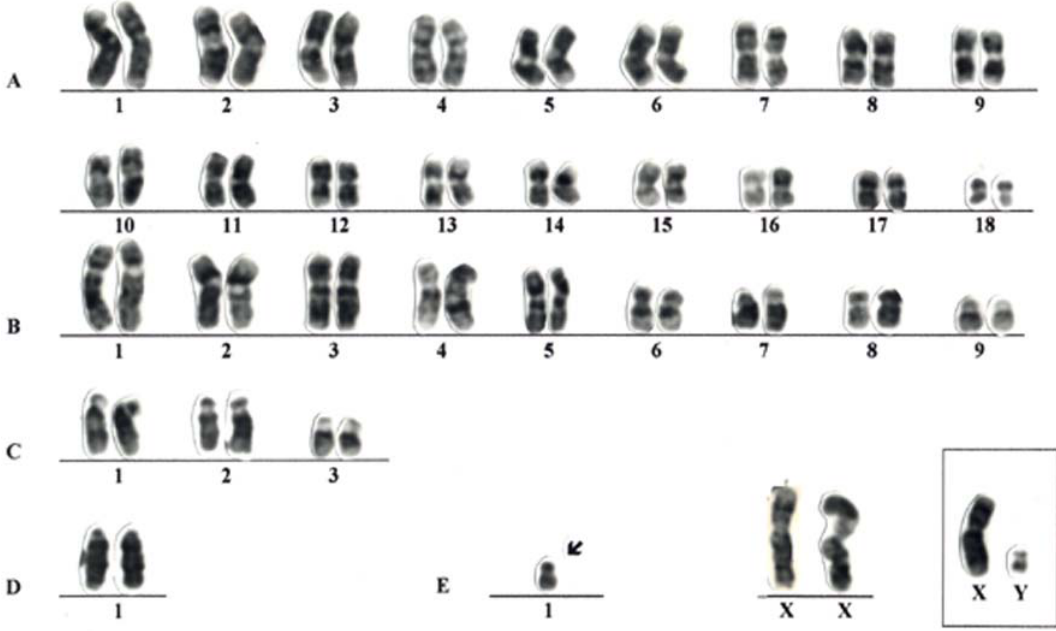
Fig. 4 – Banding G (GTG) standard of the lineage 2n=65 from a female sample of D. fuliginosa . The arrow points to the banded supernumerary chromosome. Standing out, it appears the sexual pair: X andY chromosomes, from a male of D. prymnolopha .